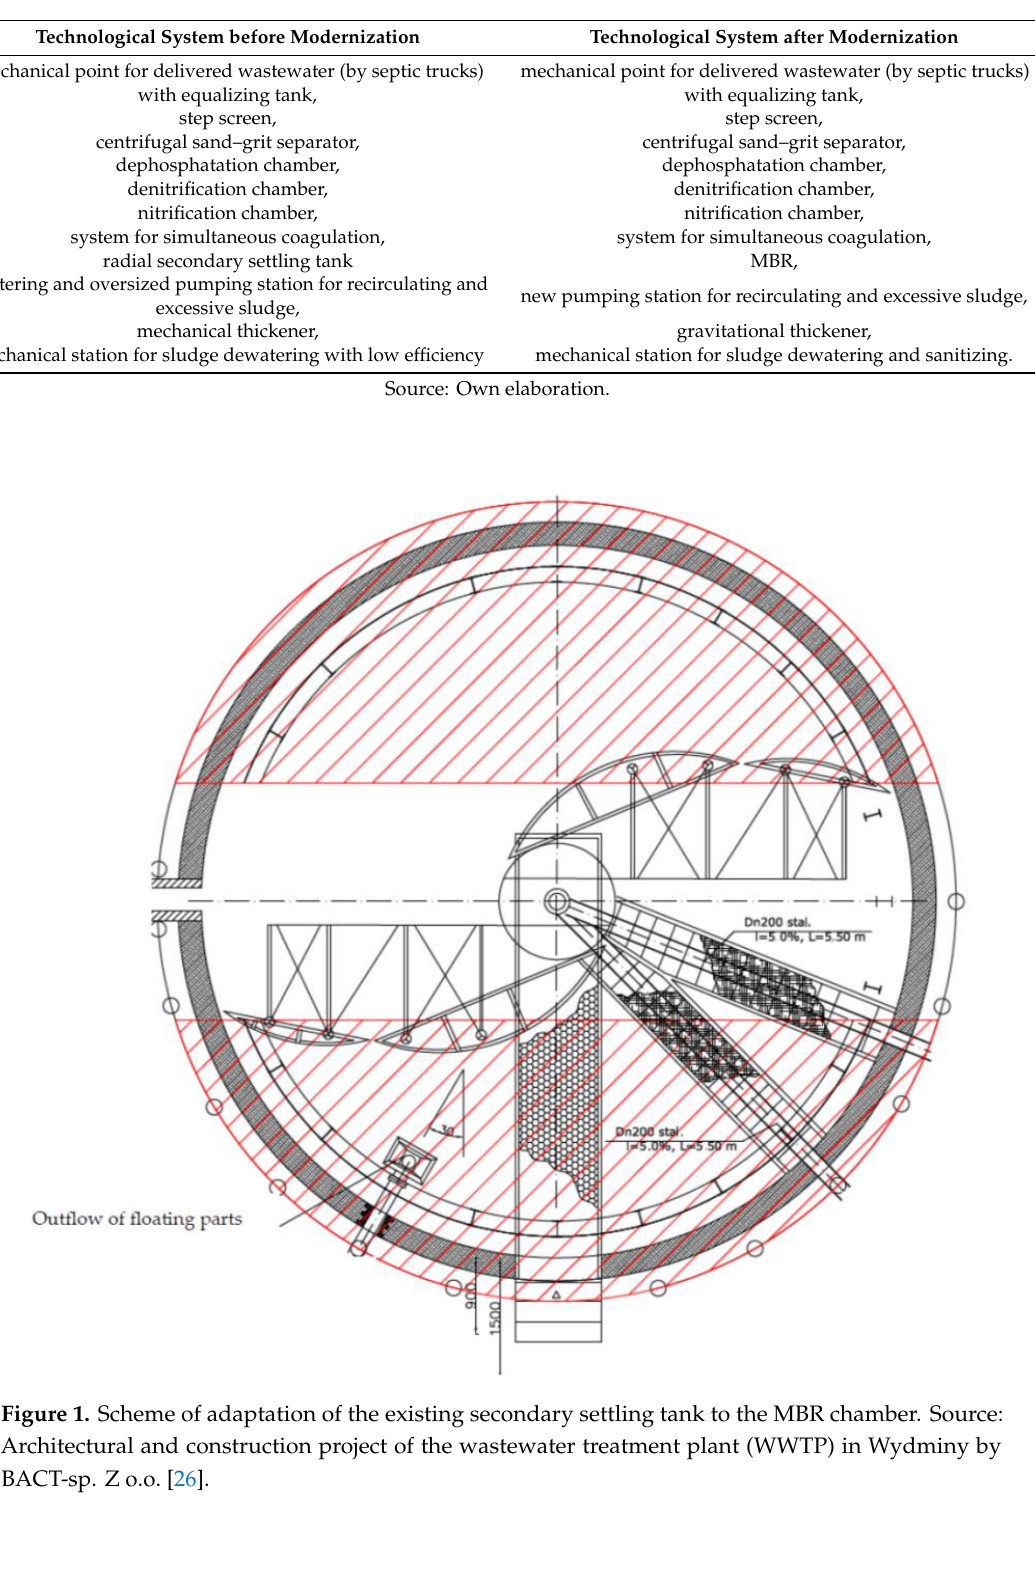
Table 4. Comparison of wastewater treatment equipment in Wydminy before and after modernization. MBR, membrane bioreactor.